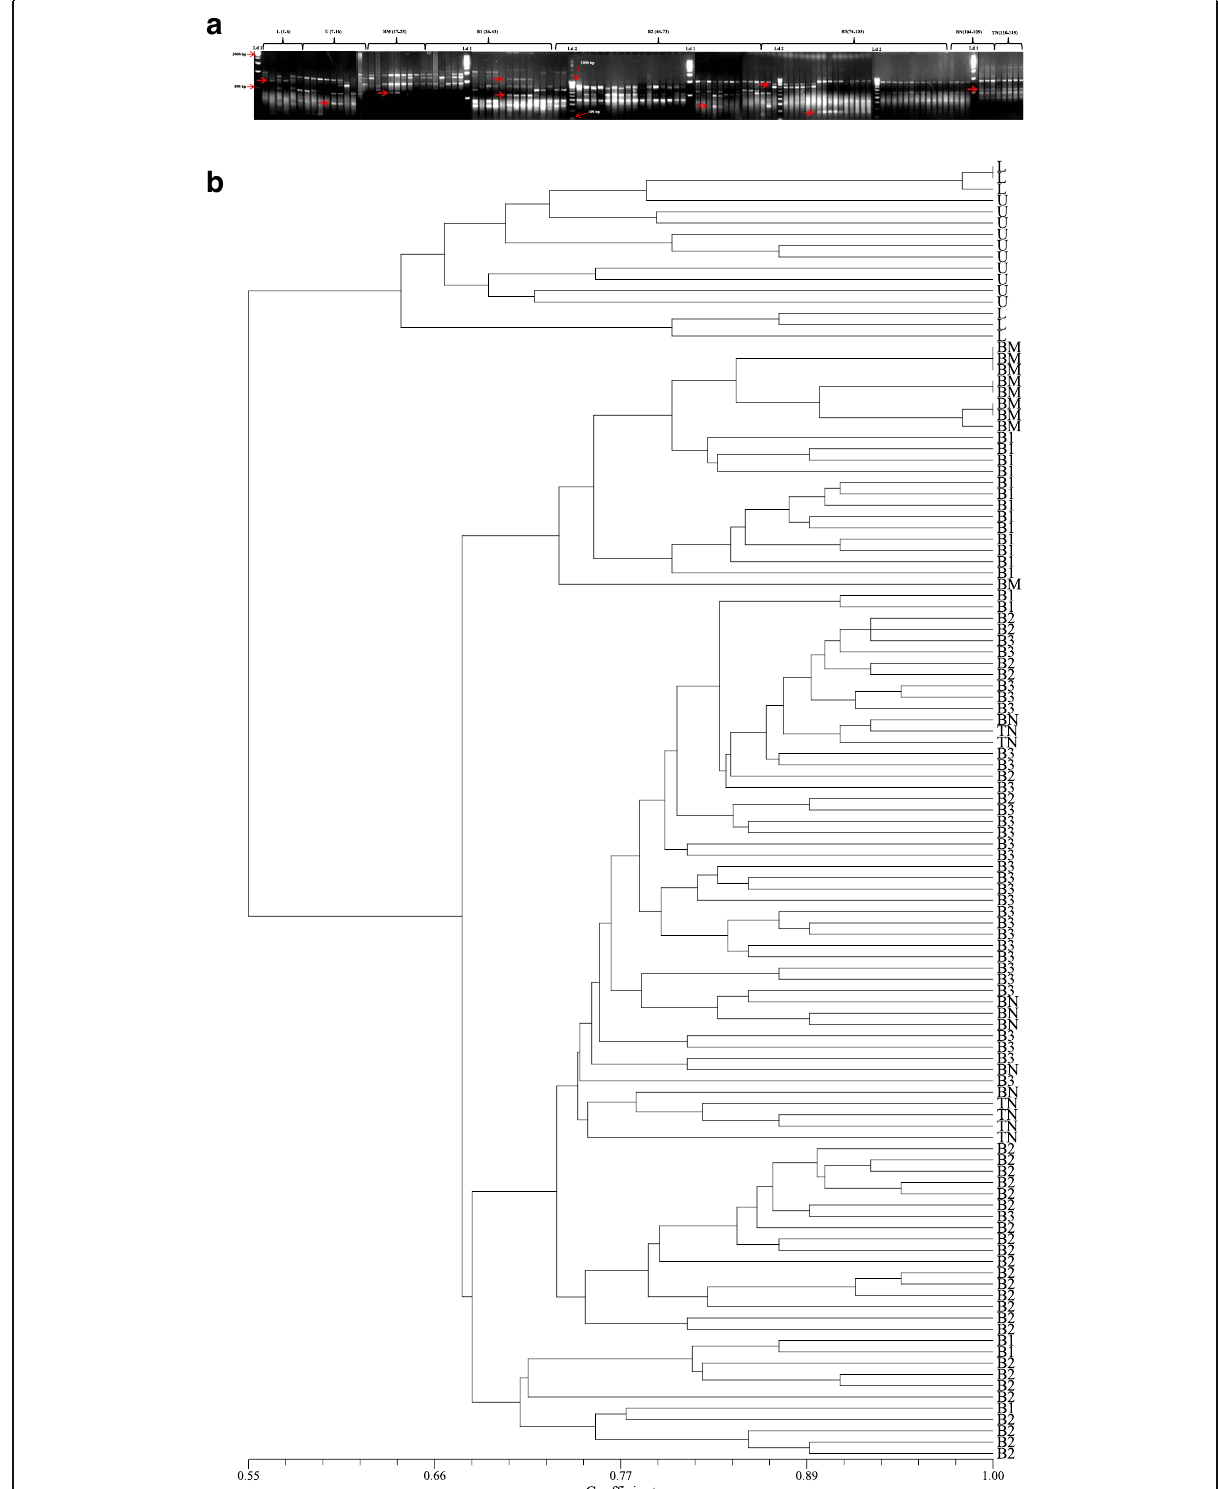
Fig. 6 SCoT profiles; a Banding profile in I. griffithii populations using primer SCOT-1, b Genetic distance recorded with SCoT primers